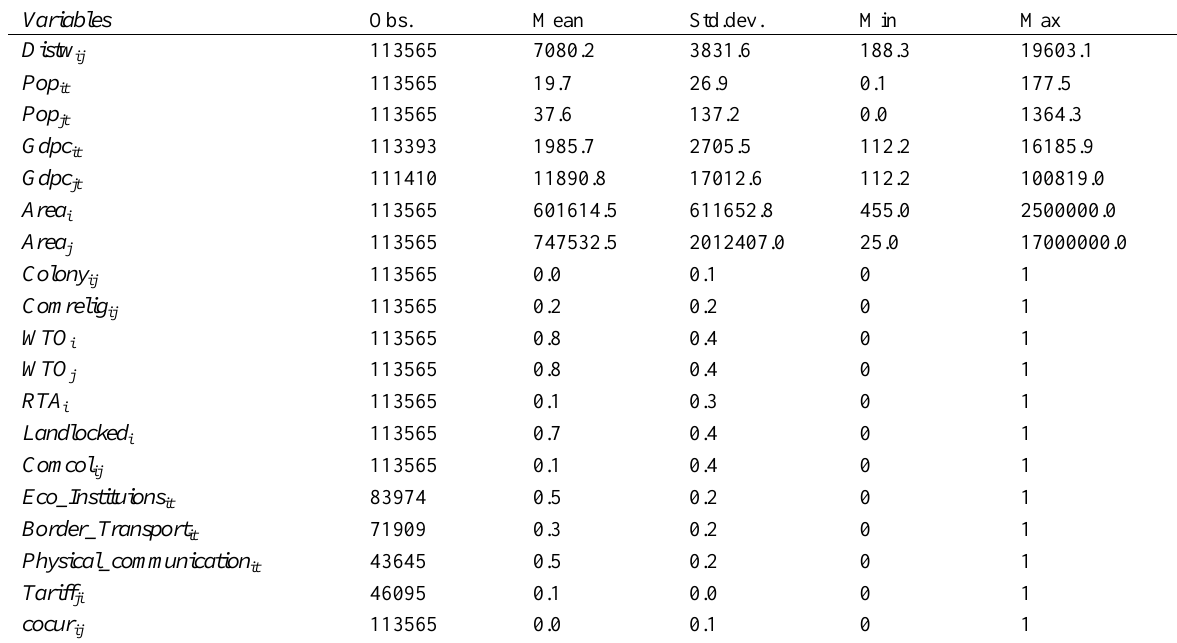
Table 8 : Summary statistics of